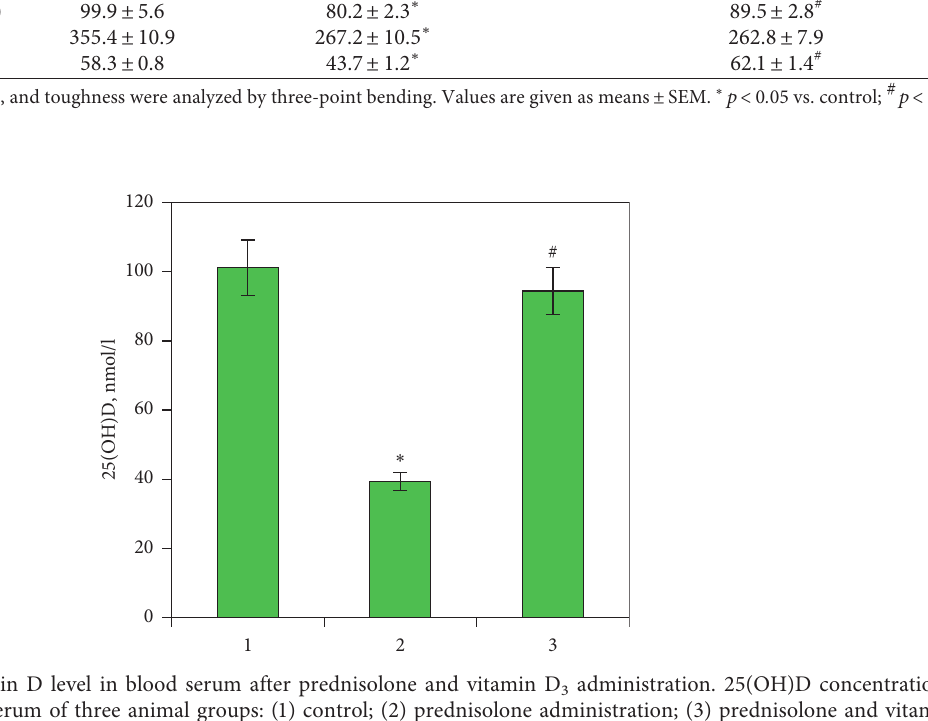
Table 2: Cortical bone strength of rat femurs after prednisolone and vitamin D Groups